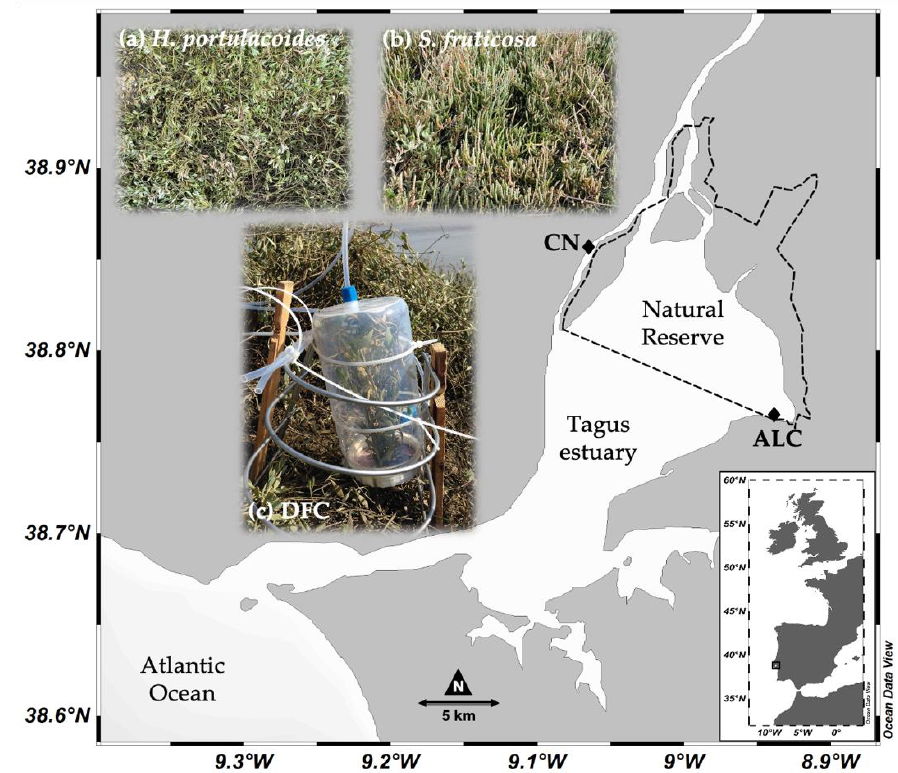
Figure 1. Location of the saltmarsh study areas in the Tagus estuary, Portugal, and the plant species studied. Background site Alcochete (ALC); industrial site Cala Norte (CN); ( a ) Halimione portulacoides ; ( b ) Sarcorcornia fruticosa ; and ( c ) dynamic flux chamber (DFC) used in the field experiments.